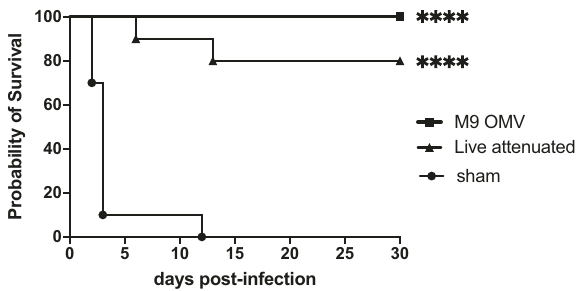
Fig. 3 M9 OMV vaccine provides signi fi cant protection against pneumonic melioidosis. Mice ( n = 10 per group) were immunized with 10 μ g M9 OMVs, 10 6 cfu live Bp82, or saline (sham). Animals were challenged with 8 x LD 50 aerosolized B. pseudomallei strain K96243. Both M9 OMV-immunized mice and mice immunized with the live-attenuated Bp82 vaccine were signi fi cantly protected against B. pseudomallei infection (**** p < 0.0001 by log rank Mantel – Cox test compared to sham). There was no signi fi cant difference between M9 OMV and live Bp82 vaccinated mice ( p = 0.14, hazard ratio 7.8, CI 0.48 – 125.1). Results shown are representa- tive of two independent